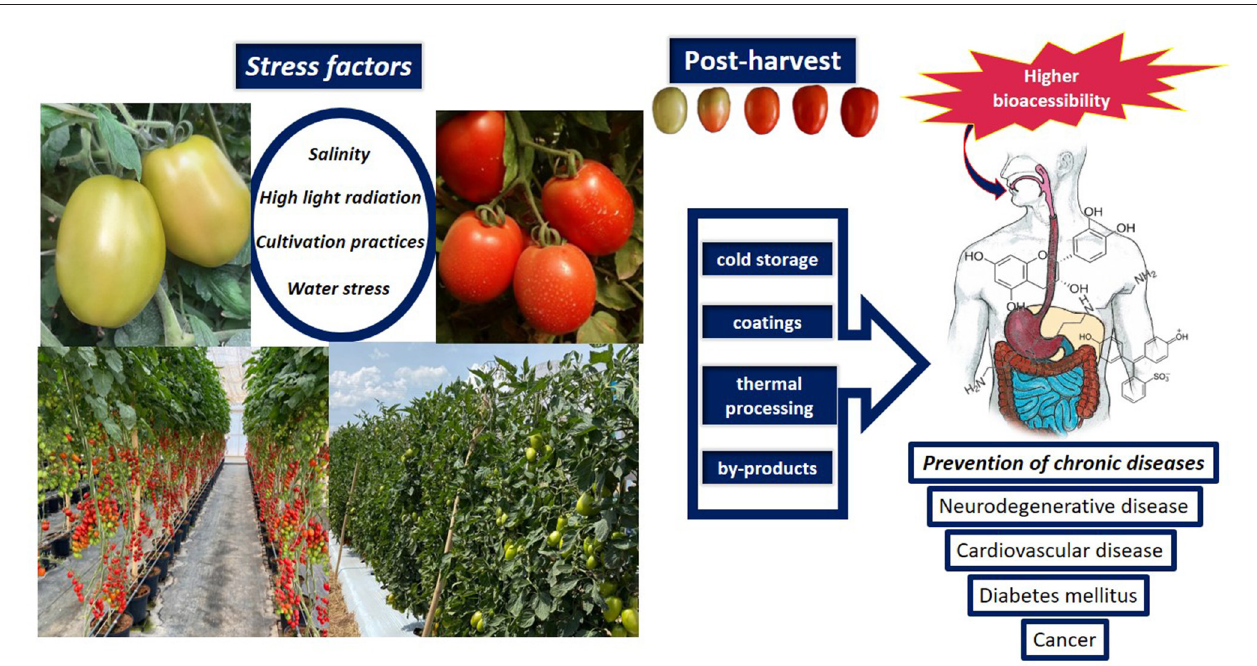
FIGURE 2 | Influence of biotic and abiotic factors on the bioaccessibility and bioavailability of tomato bioactive compounds.